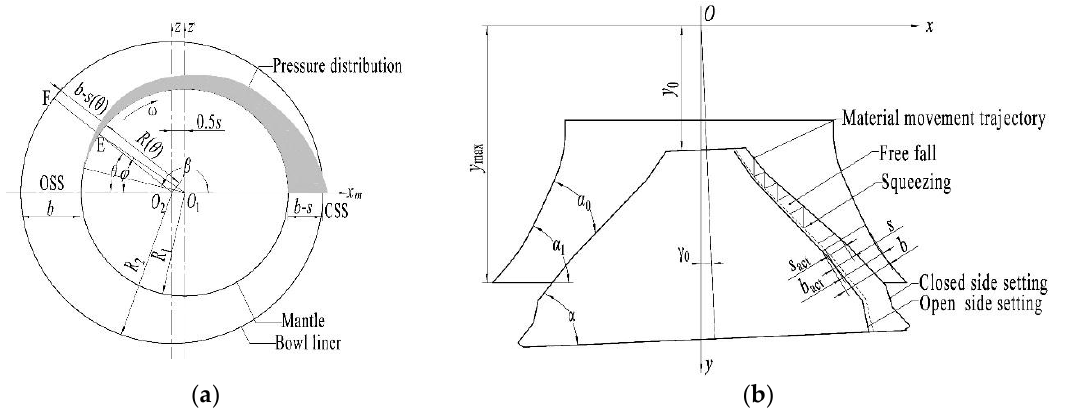
Figure 1. Cross section of crushing chamber: ( a ) surface pressure distribution of the mantle; ( b ) material movement trajectory.